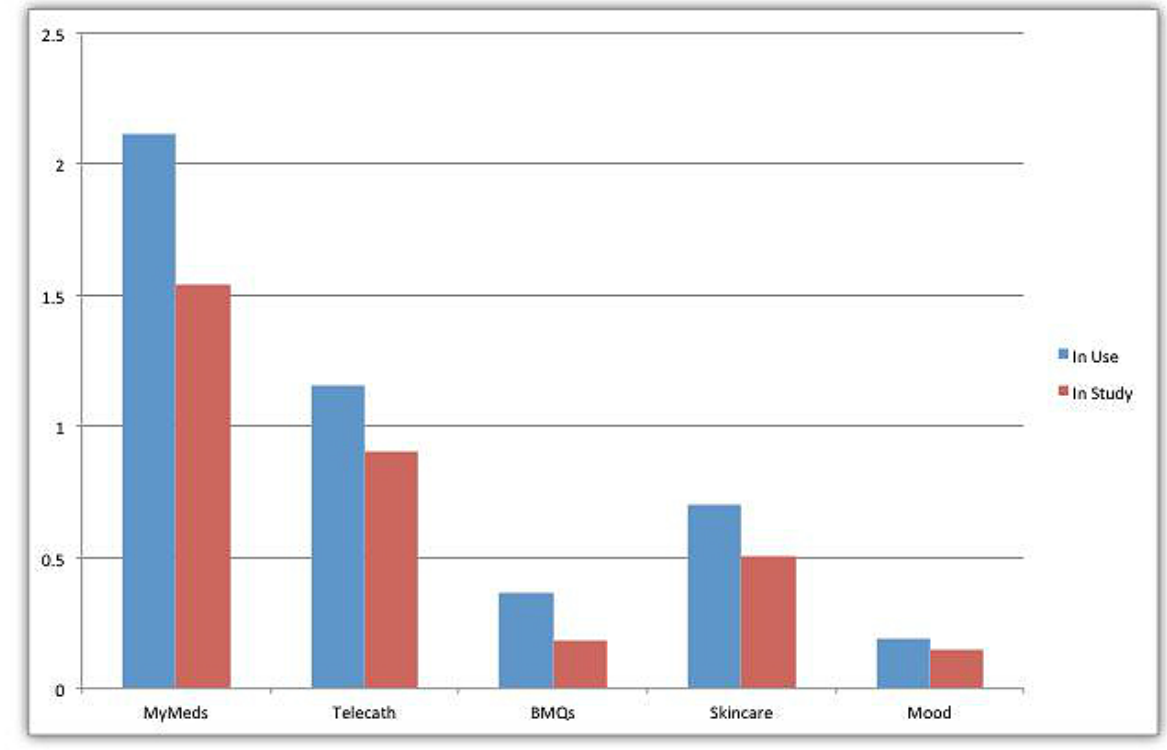
Figure 10. Average daily usage of app